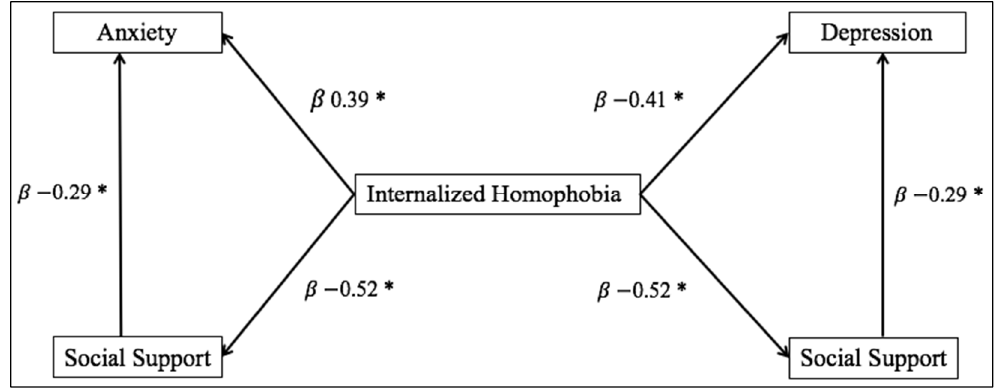
Figure 2. Path Analysis Model of relation between interiorized homophobia variables, anxiety, depression and Social Support among the male Belgian sample, * p < 0.05